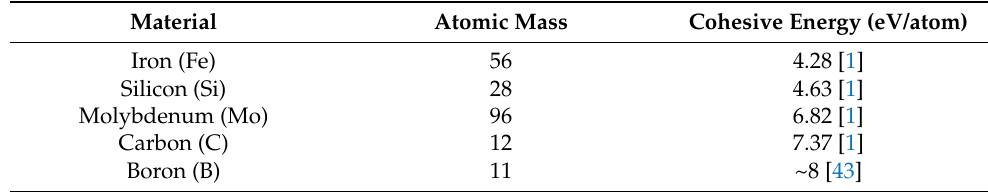
Table 3. Atomic mass and cohesive energy of carbon and doping materials.